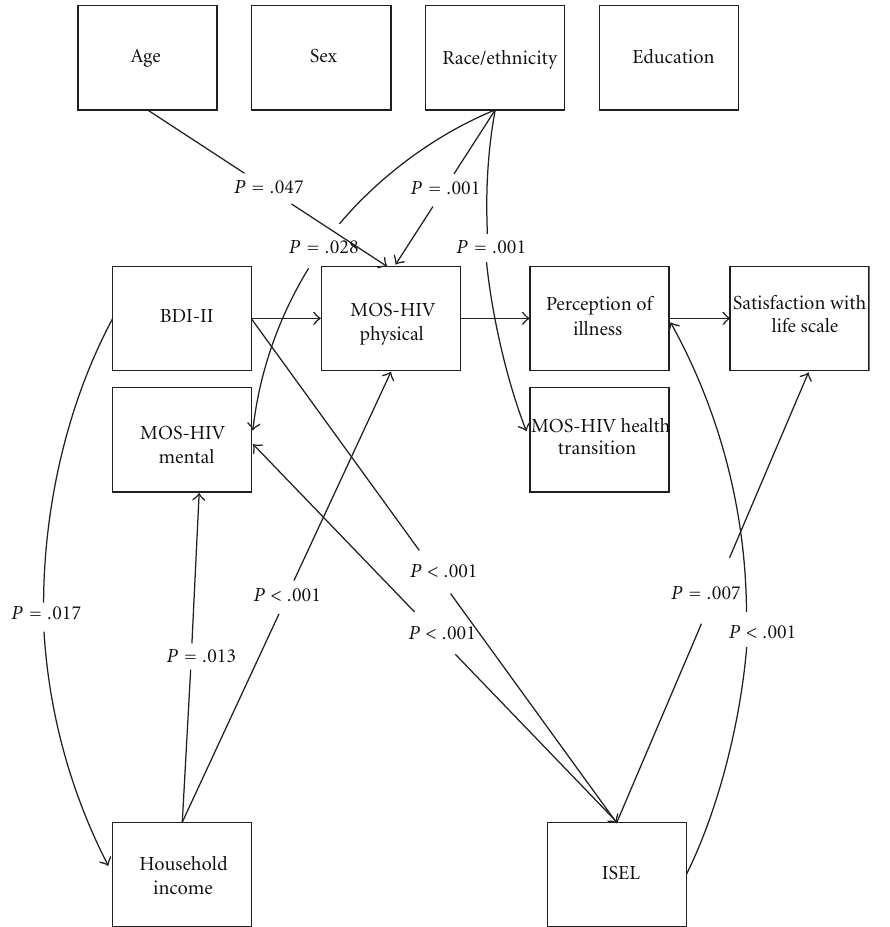
Figure 4: SEM with significant covariate model pathways